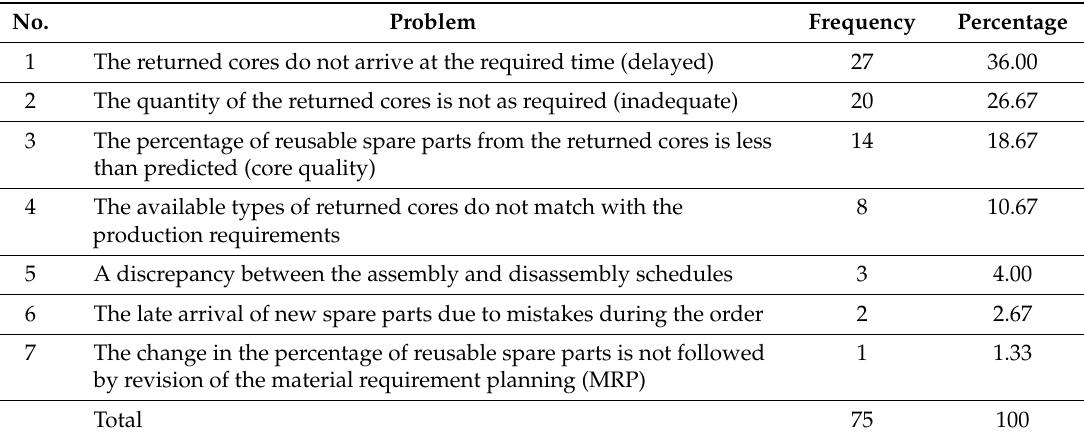
Table 7. HeavyEq’s problems for the period August 2015 to October